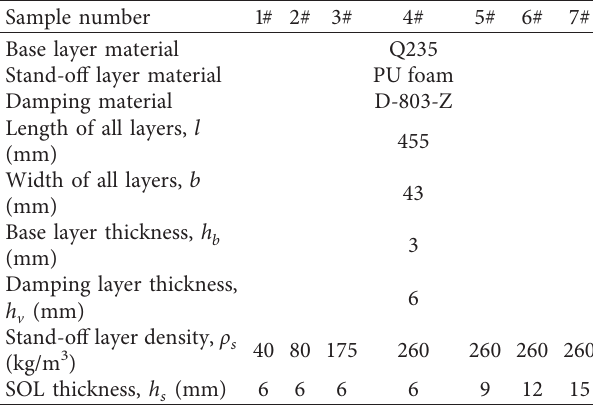
Table 1: Beam parameters and number. Sample